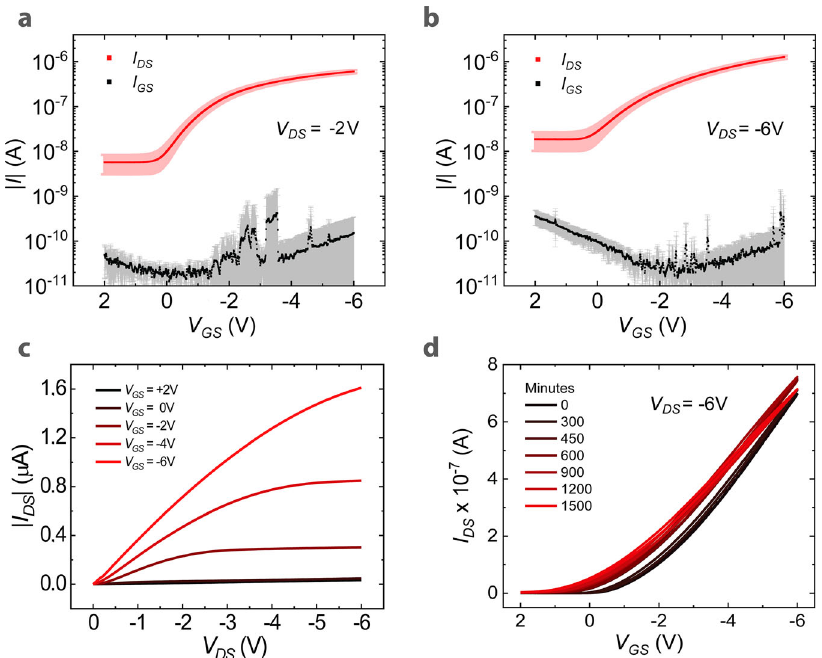
Fig. 3 Electrical characterization of the organic transistors. Average transfer characteristic curves, with their standard deviation, obtained on eight ultrathin devices based on 29-DPP-TVT in a linear and b saturation regimes. c Typical output characteristic curve for a 29-DPP-TVT-based ultrathin transistor. d Transfer characteristic curve acquired consecutively in ambient air as a function of time for an ultrathin